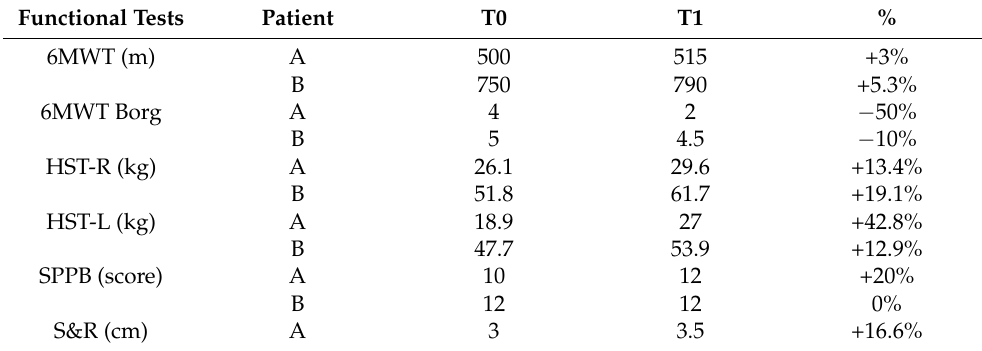
Table 2. Patient A and B functional assessment before (T0) and after (T1) interventions. The compar- isons between pre- and post-intervention data are expressed by the percentage variation